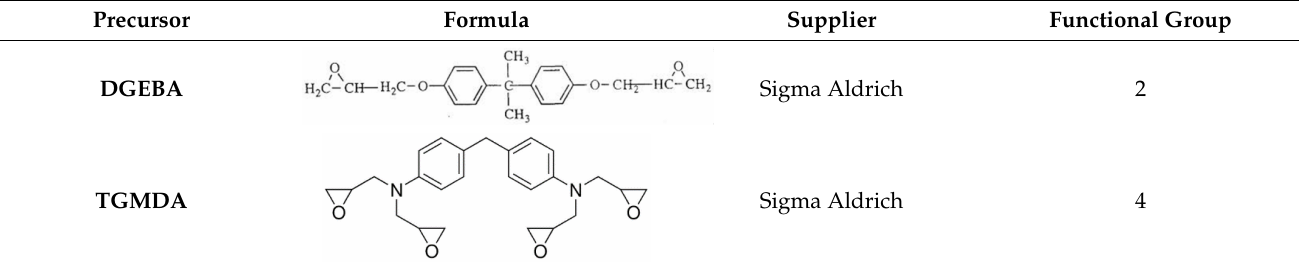
Table 2. Chemical formulas of the two epoxy precursors, functionality and supplier.